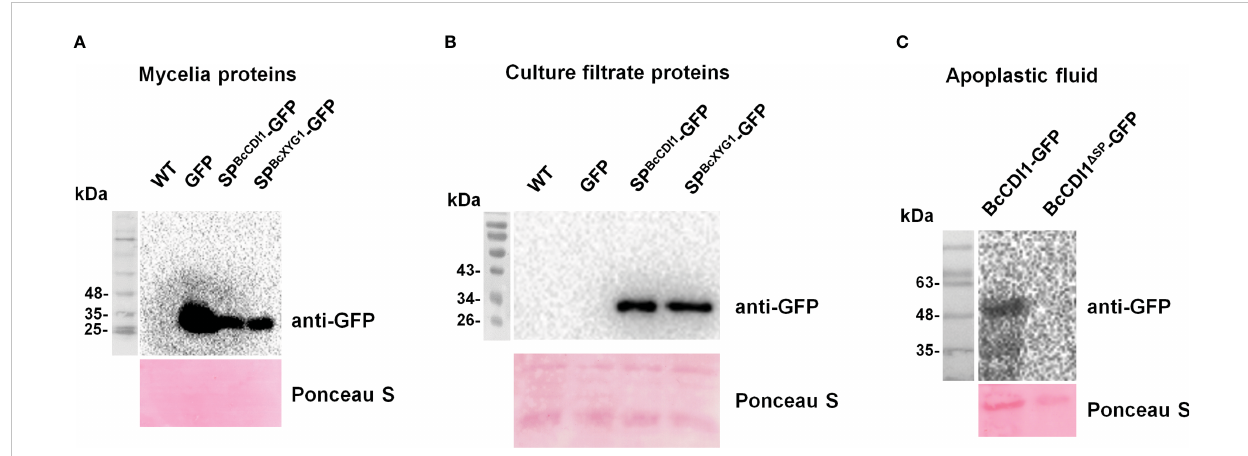
FIGURE 2 BcCDI1 signal peptide possesses secretion function. (A) Immunoblot analysis of the total mycelial proteins from the indicated Botrytis cinerea strains. Top panel, immunoblot using anti-GFP antibody; bottom panel, Ponceau S staining of the total mycelial proteins. (B) Immunoblot analysis of culture fi ltrate proteins from the indicated B cinerea strains. Top panel, immunoblot using anti-GFP antibody; bottom panel, Ponceau S staining of the secreted proteins. SP BcCDI1 -GFP, GFP fused with the signal peptide of BcCDI1; SP BcXYG1 -GFP, GFP fused with the signal peptide of BcXYG1; GFP, GFP overexpression strain; WT, wild-type strain. (C) Western blotting analysis of apoplastic fl uid from Nicotiana benthamiana leaves agroin fi ltrated with BcCDI1-GFP or BcCDI1 D SP -GFP for 3 days. Top panel, immunoblot using anti-GFP antibody; bottom panel, Ponceau S staining of the apoplastic fl